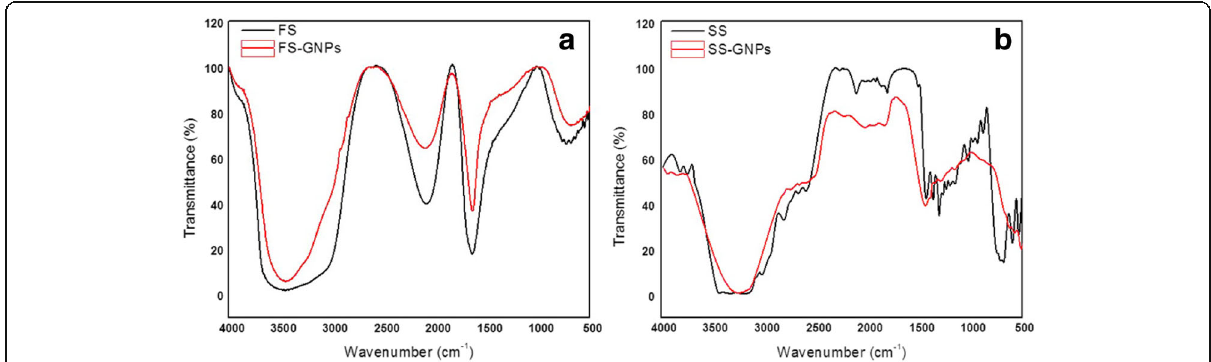
Fig. 8 FTIR spectra of a FS and FS – GNPs and b SS and SS –